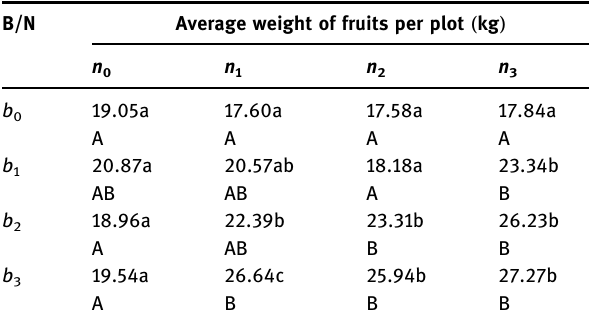
Table 5: Fermented compost and N - fertilizer on weight of fruits per plot B/N Average weight of fruits per plot ( kg